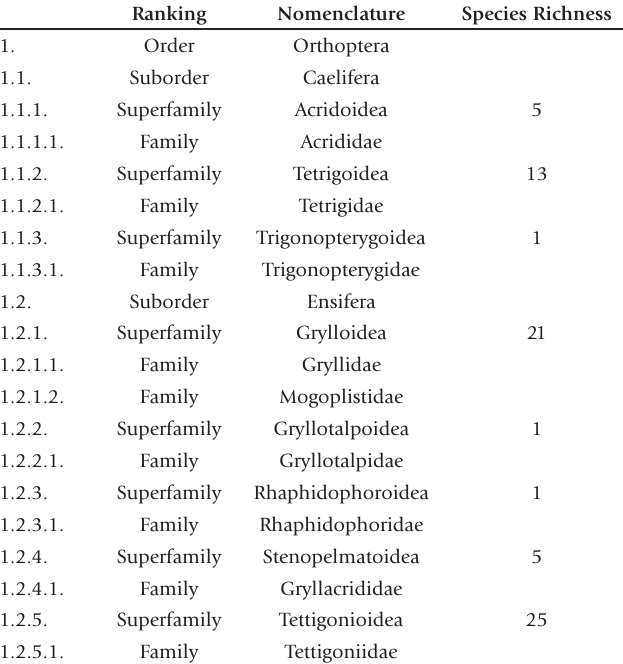
Table 1. A summary of the coverage of orthopteran superfamilies and families that were represented in the collection in